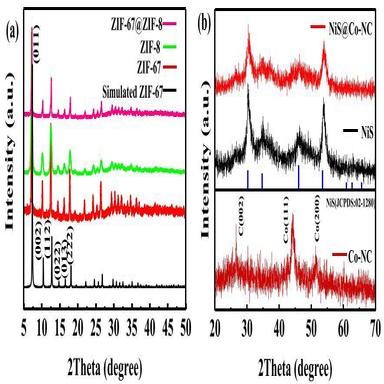
XRD patterns of simulated ZIF-67 and synthesized ZIF-67, ZIF-8, ZIF-67 @ZIF-8 (a) and Co-NC, NiS, NiS@Co-NC (b).